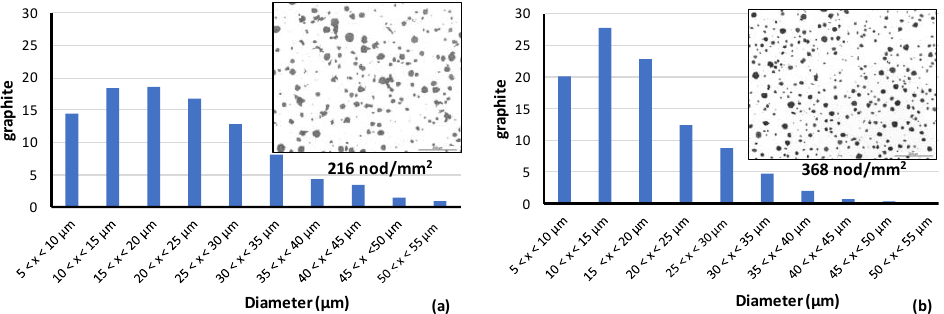
Figure 7. Unetched micrographs and graphite size distribution for samples from Heat 3 non inocu- lated ( a ) and inoculated with Ce-inoculant ( b ).